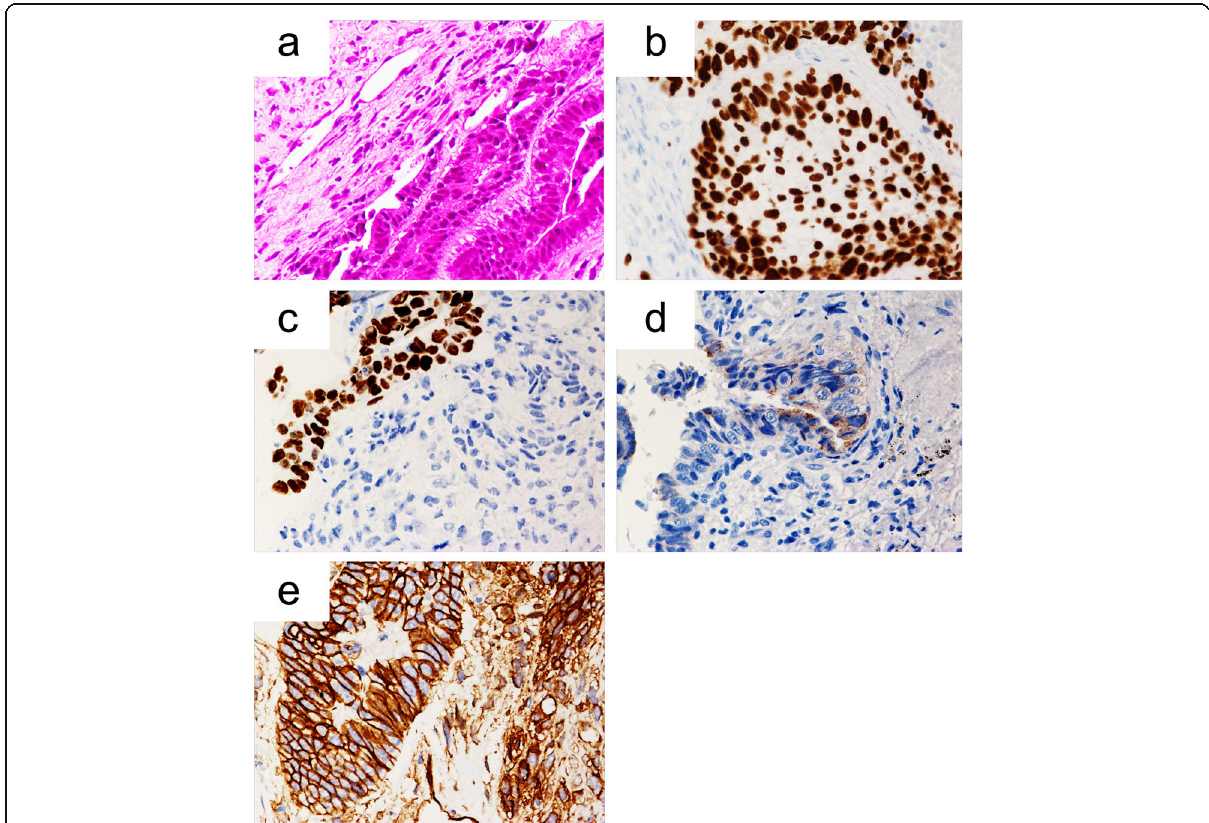
Fig. 3 On the histopathological examination, H-FLAC exhibits the absence of morule formation ( a : H&E staining, × 100 objective lens). Immunohistochemically, the tumor cells were positive for p53 ( b , × 200 objective lens), SALL4 ( c , × 200 objective lens), and Glypican3 ( d , × 200 objective lens). The tumor cells showed membranous staining of β -catenin ( e , × 200 objective